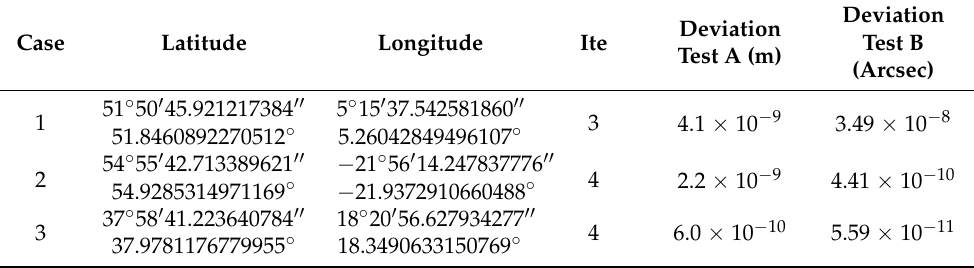
Table 6. Minimum distance solution using PostGIS through the ST_GeodesicMinDistance new implemented SQL function. Values of latitude and longitude given in deg min sec as well as in decimal degrees. The column Ite is the number of iterations, the last column (Deviation) gives the computation of deviation with extended precision using the Maxima framework as explained in the next section.